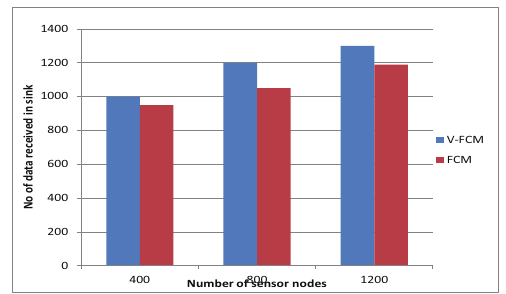
Fig: 7 No of data received data in sink node VS number of nodes.